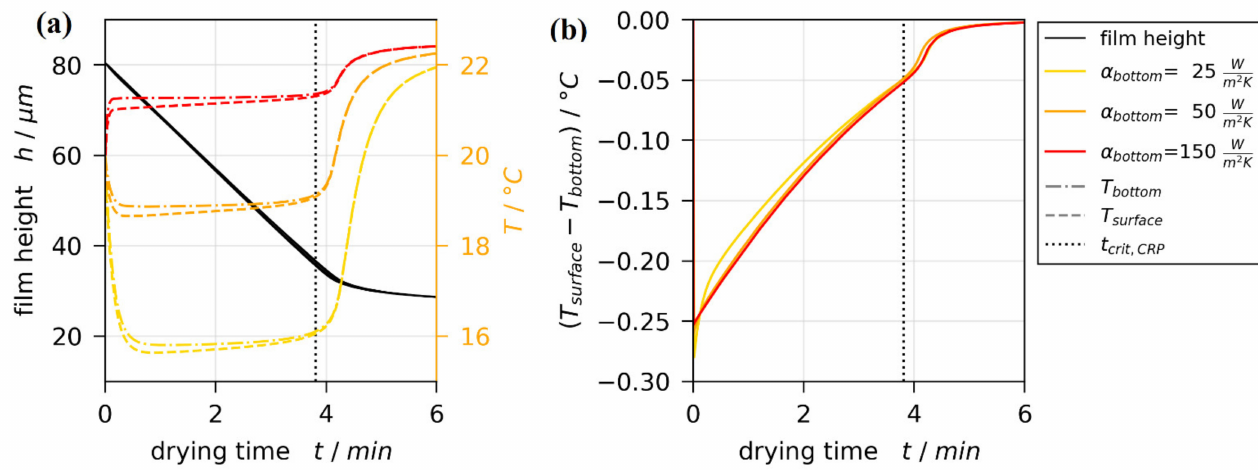
Figure 8. Results from a non-isothermal 1D drying simulation with X 0 = 1.5 g variation. The dotted vertical line indicates the end of the constant rate period t crit , CRP . ( a ) Drying curves and temperatures at bottom and surface of the drying film. ( b ) Vertical temperature difference between surface and bottom of the